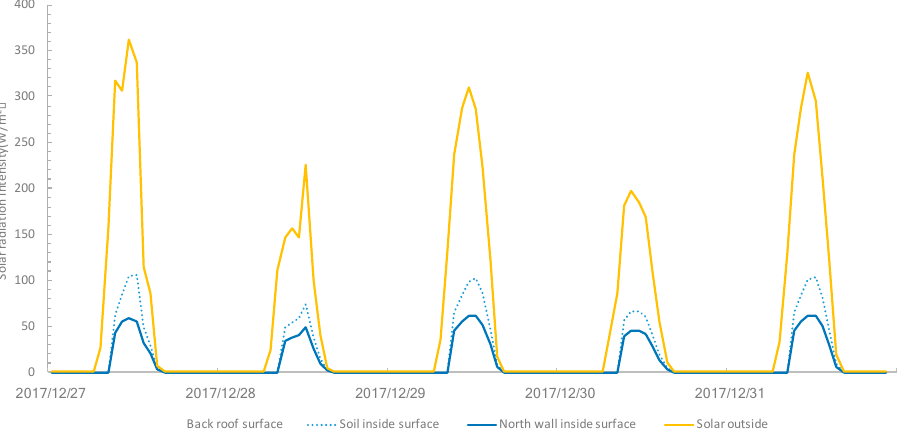
Figure 19. Solar radiation heat gain rate inside the surfaces of the CSG on cloudy days. On cloudy days, the sequence of the energy distribution was the same as that on clear days, but the decrease in quantity of energy is obvious. The solar energy received by the soil was about 70 W/m 2 and the north wall absorption was below 50 W/m 2 . The simulated results are consistent with the solar radiation data of simulated surfaces in another heat